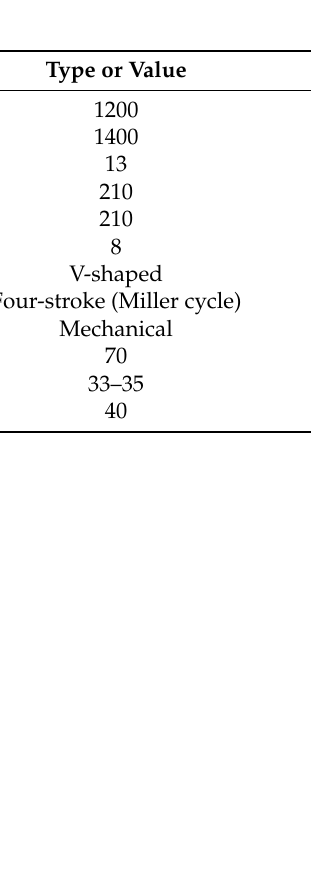
Figure 1. Three-dimensional model of the investigated diesel engine: 1—temperature controller; 2— water pump; 3—water–oil cooler; 4—executive device of the speed regulator; 5—water